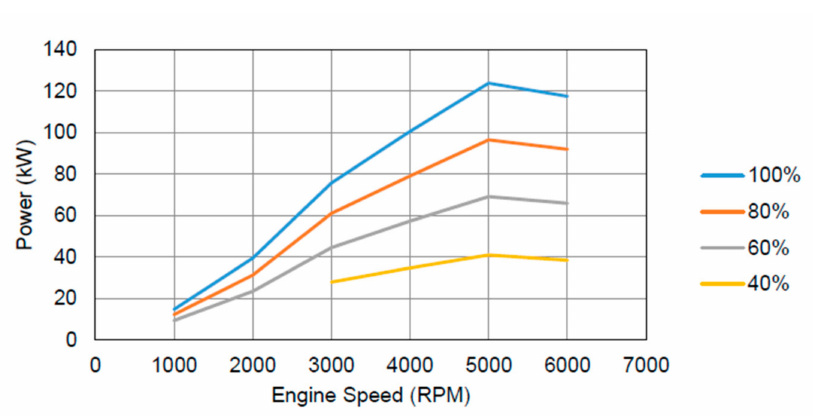
Figure 17. Baseline engine torque at di ff erent engine speeds.